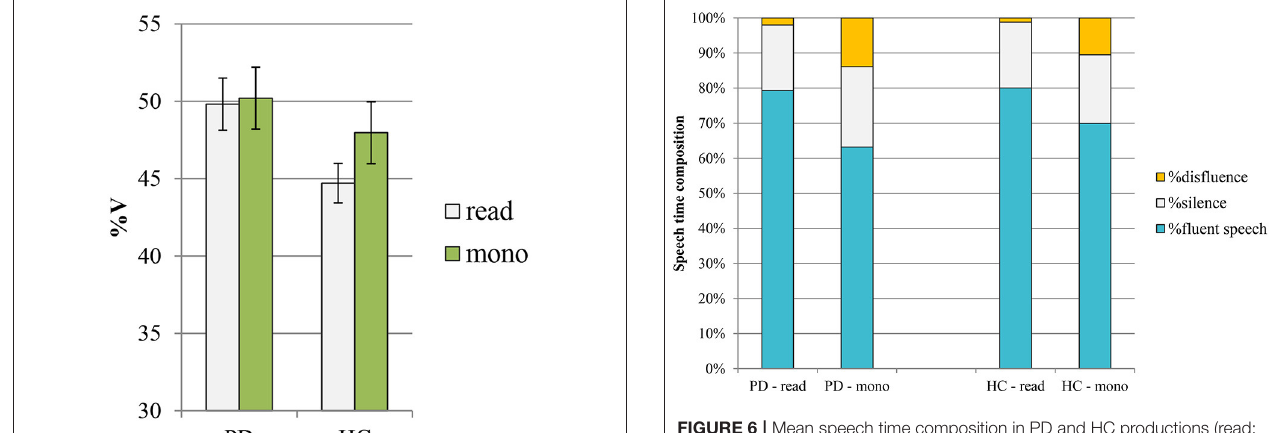
FIGURE 6 | Mean speech time composition in PD and HC productions (read: reading task; mono: monolog). PD, Parkinson’s disease; HC, healthy control.